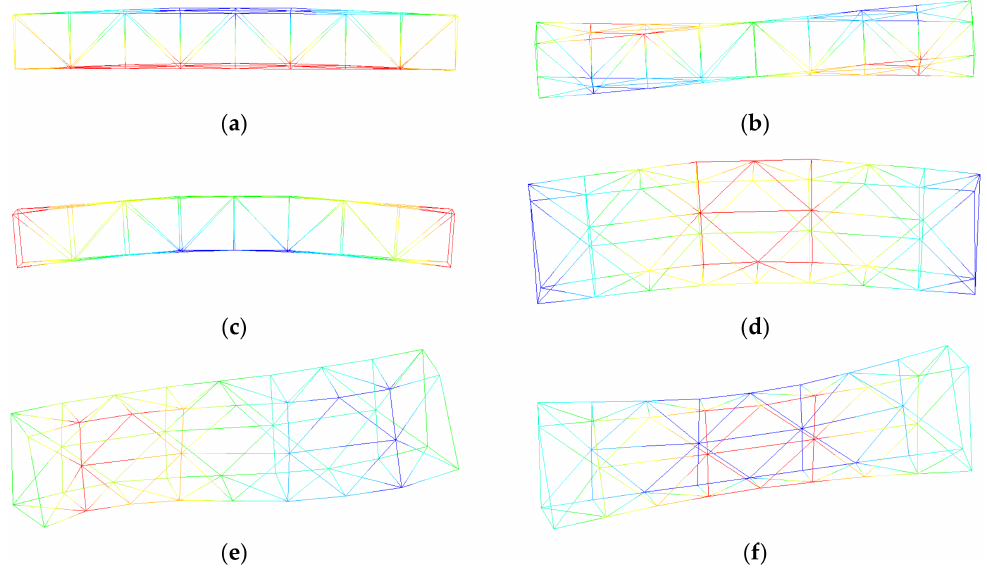
Figure 5. The first six mode shapes of the truss: ( a ) first order mode; ( b ) the second mode; ( c ) the third mode; ( d ) the fourth mode; ( e ) the fifth mode; and ( f ) the sixth